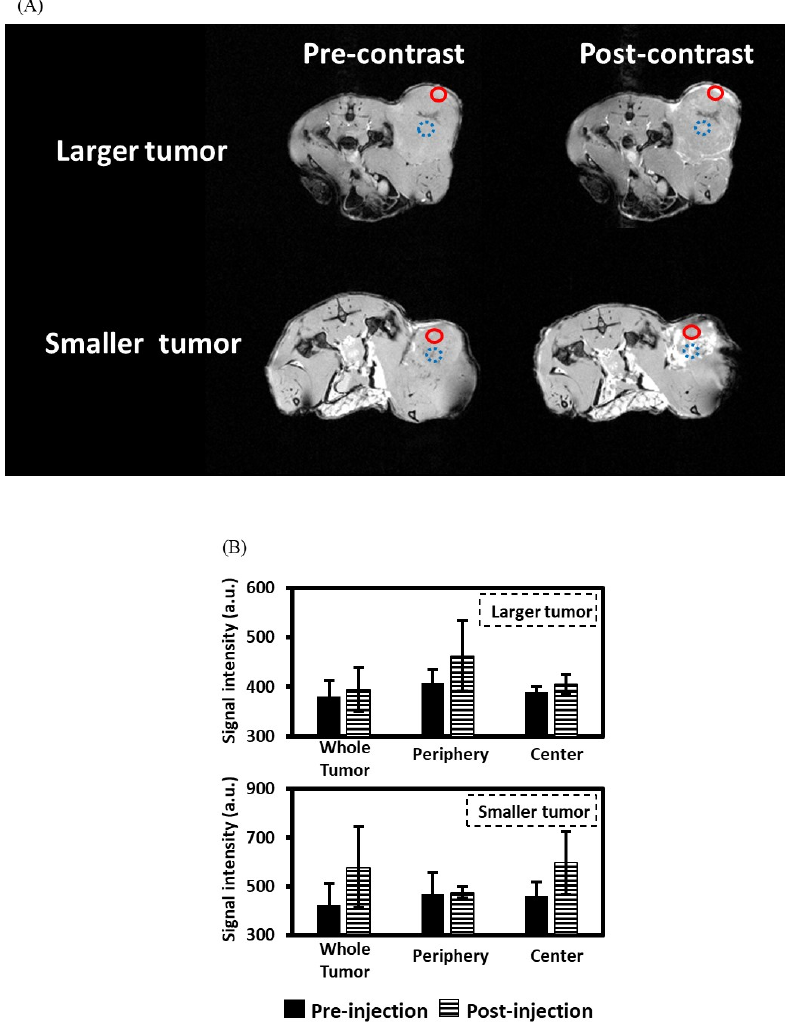
Figure 4. MR images from representative rats with either 250 ± 50 mm 3 (larger) or 100 ± 50 mm 3 (smaller) xenograft tumors. ( A ) MR images before and after 1 h PLGA-BC/Gd-AuNP injection. The red circles with a solid line indicate the location of the tumor periphery while the blue circles with a dashed line indicate the location of the tumor center. ( B ) Comparisons of signal intensities before and after 1 h PLGA-BC/Gd-AuNP injection.